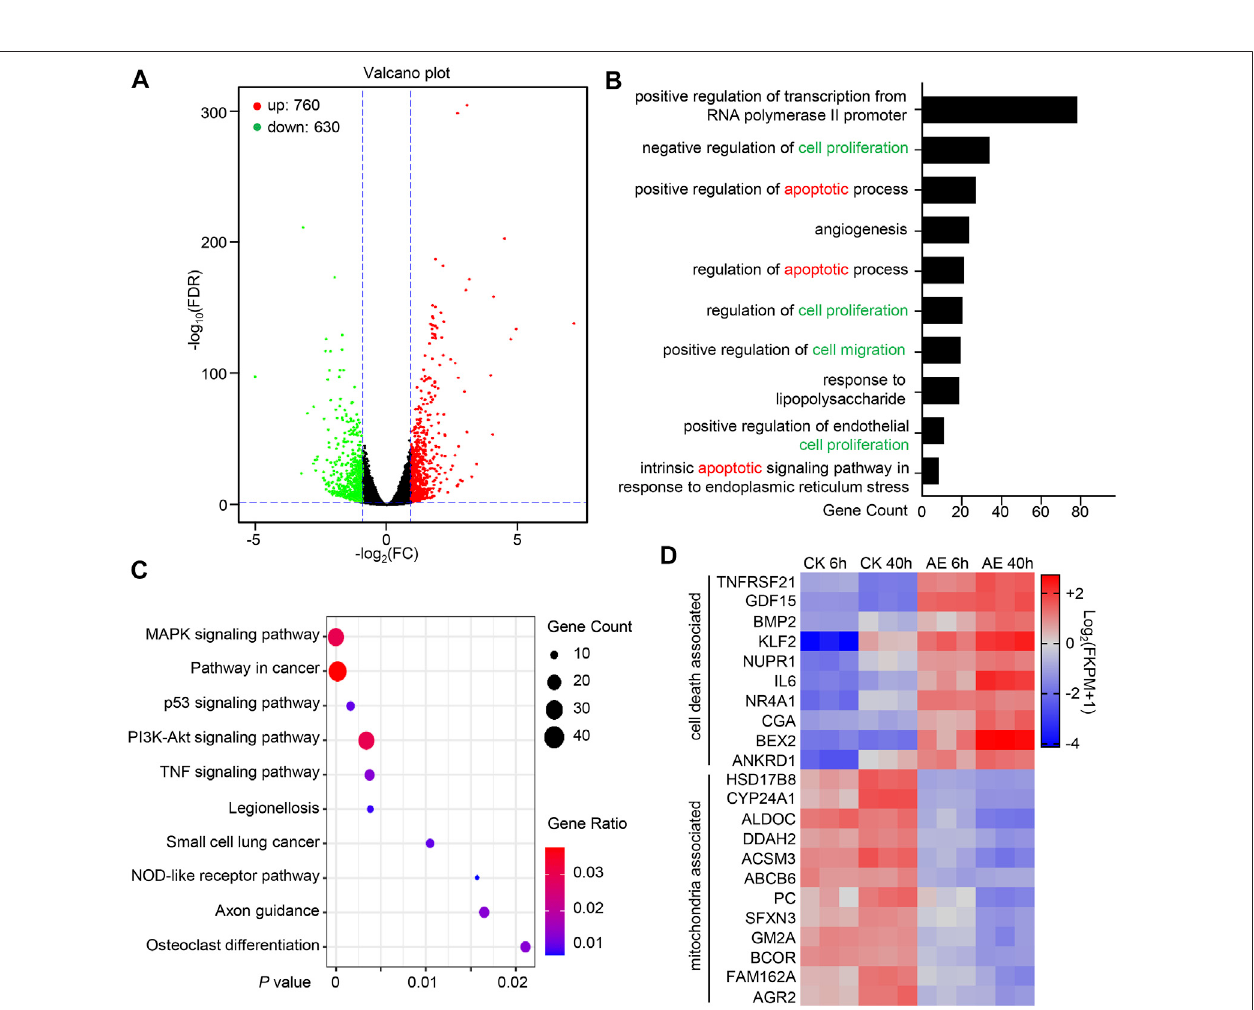
FIGURE 6 | Systematically Transcriptional Analysis of AE-treated HeLa cells. (A) Volcano map shows DEGs ’ overall scatter in HeLa cells at 6 h post-treatment. Each point represents a speci fi c gene transcript. The abscissa indicates the fold-change of gene expression in AE-treated samples divided by those in control samples. The ordinate shows the statistical test valuesfor thesigni fi cantdifference in expression. Reddots correspondtoup-regulated genes, green dotsrefertothe signi fi cantly down-regulated genes, and black dots indicate a non-signi fi cant change in gene expression. (B) Gene Ontology (GO) enrichment analysis of the DEGs into biological processes using the DAVID (the Database for Annotation, Visualization, and Integrated Discovery) online analysis tool (https://david.ncifcrf.gov/). The lower abscissa indicates the number of genes annotated to a speci fi c GO term. (C) Kyoto Encyclopedia of Genes and Genomes (KEGG) pathway enrichment analysis of the DEGsusingtheDAVIDonlineanalysistool.Thehorizontalaxisrepresentsthe p-value .Thebigcircleindicatesamoresigni fi cantnumberofDEGsenrichedinthisfunction. (D) Heatmap shows the synergistic expression patterns of the DEGs involved in regulating cell death or mitochondrial function at 6 h or 40 h post-AE treatment. Color change (from blue to red) indicated that the relative intensity changed from low to